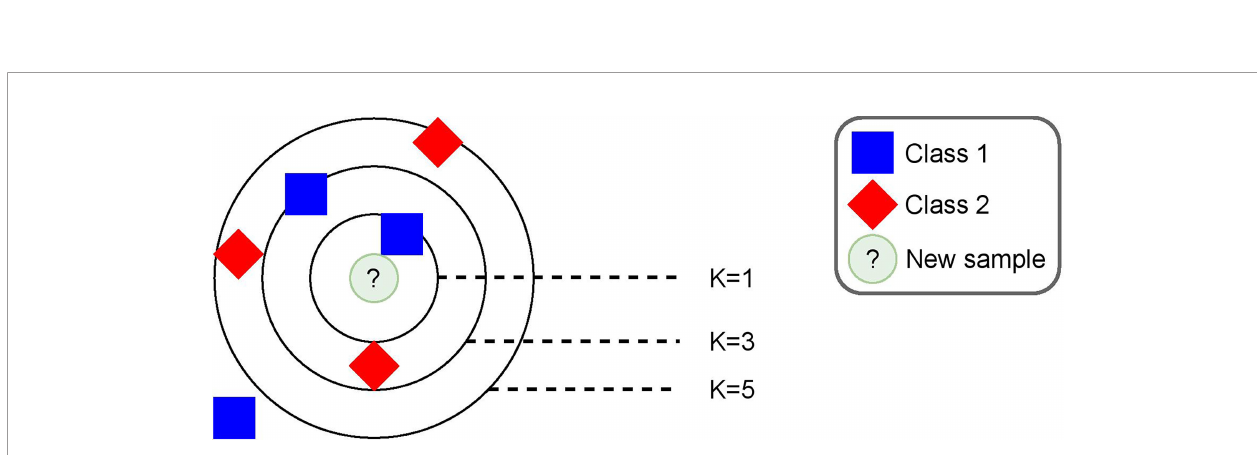
FIGURE 3 | Intuitive diagram of KNN.